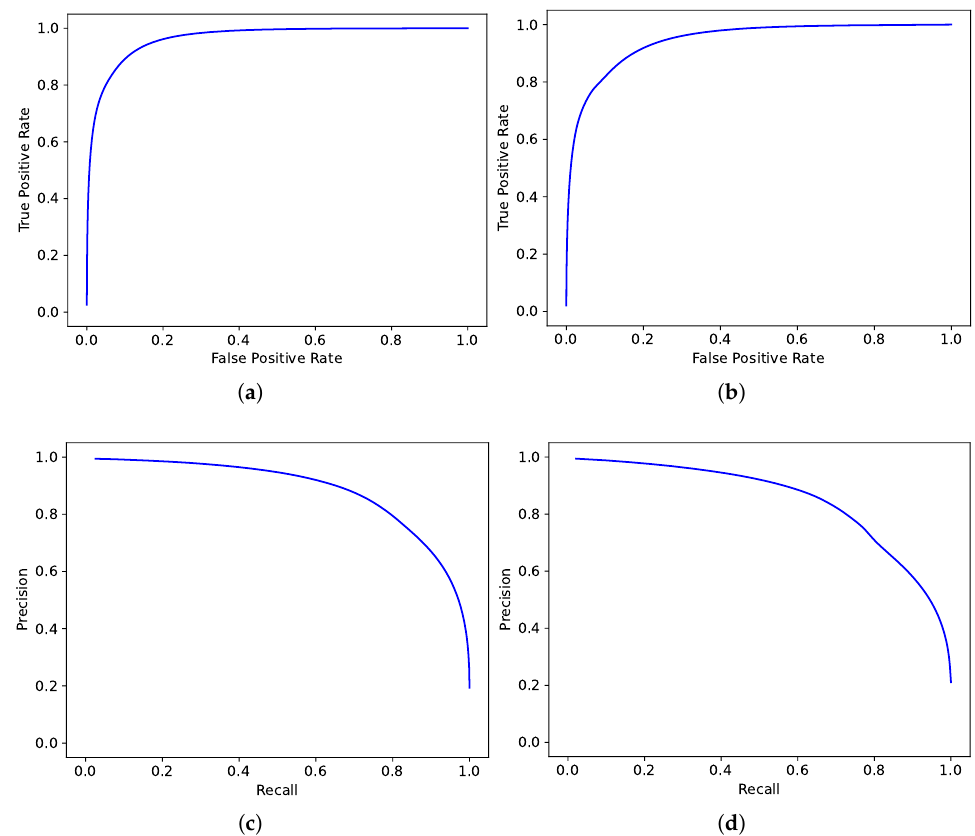
Figure 13. Receiver operating and precision-recall curves for the two largest test sets in our study: GDBX L and GDBX L together with the respective areas under the curve (AUC) values: tst − seen tst − unseen ( a ) receiver operating curve (ROC) for GDBX L , AUC = 0.964, ( b ) receiver operating curve (ROC) tst − seen for GDBX L , AUC = 0.944; ( c ) precision-recall curve (PRC) for GDBX L , AUC = 0.872; tst − unseen tst − seen ( d ) precision-recall curve (PRC) for GDBX L , AUC = 0.838. tst − unseen